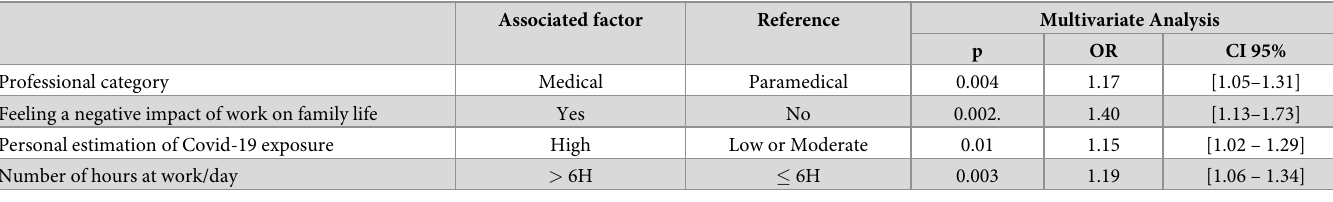
Table 4. Associated factors with burnout among health professionals during the Covid19 pandemic in Monastir (Multivariate analysis). Associated